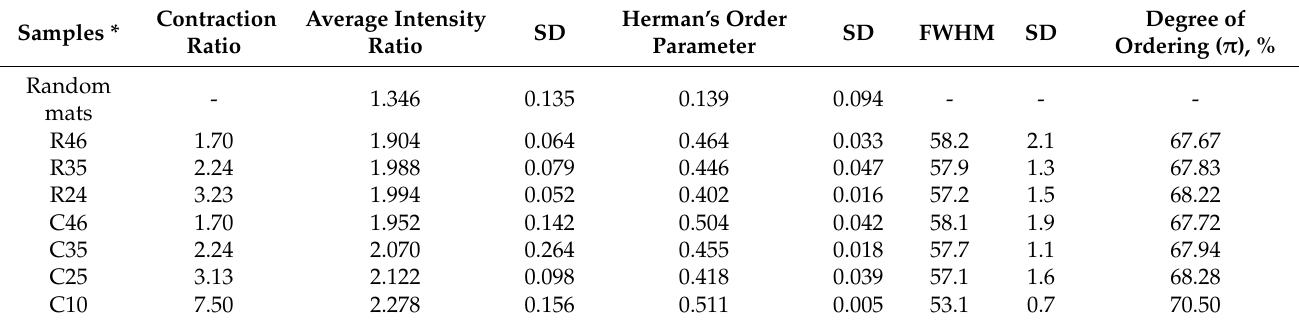
Figure 12. Azimuthal diffraction profiles for the selected fibre mats and random mats. The average intensity ratio, i.e., ratio of maximum to minimum intensity of azimuthal diffraction profiles, was calculated, and the average values for each mat are provided in Table 6. The average intensity ratio indicated an increasing trend with increasing contraction ratio. However, a significant difference (confirmed by Student’s t -test) was found only between the fibre mats made with the C10 and R46 nozzles; no significant differences were observed between nozzles with a similar contraction ratio but with a different exit shape, i.e., rectangular-round or circular. Table 6. XRD assessment of orientation of fibre mats: average intensity ratio, Herman’s order parameter, FWHM and degree of